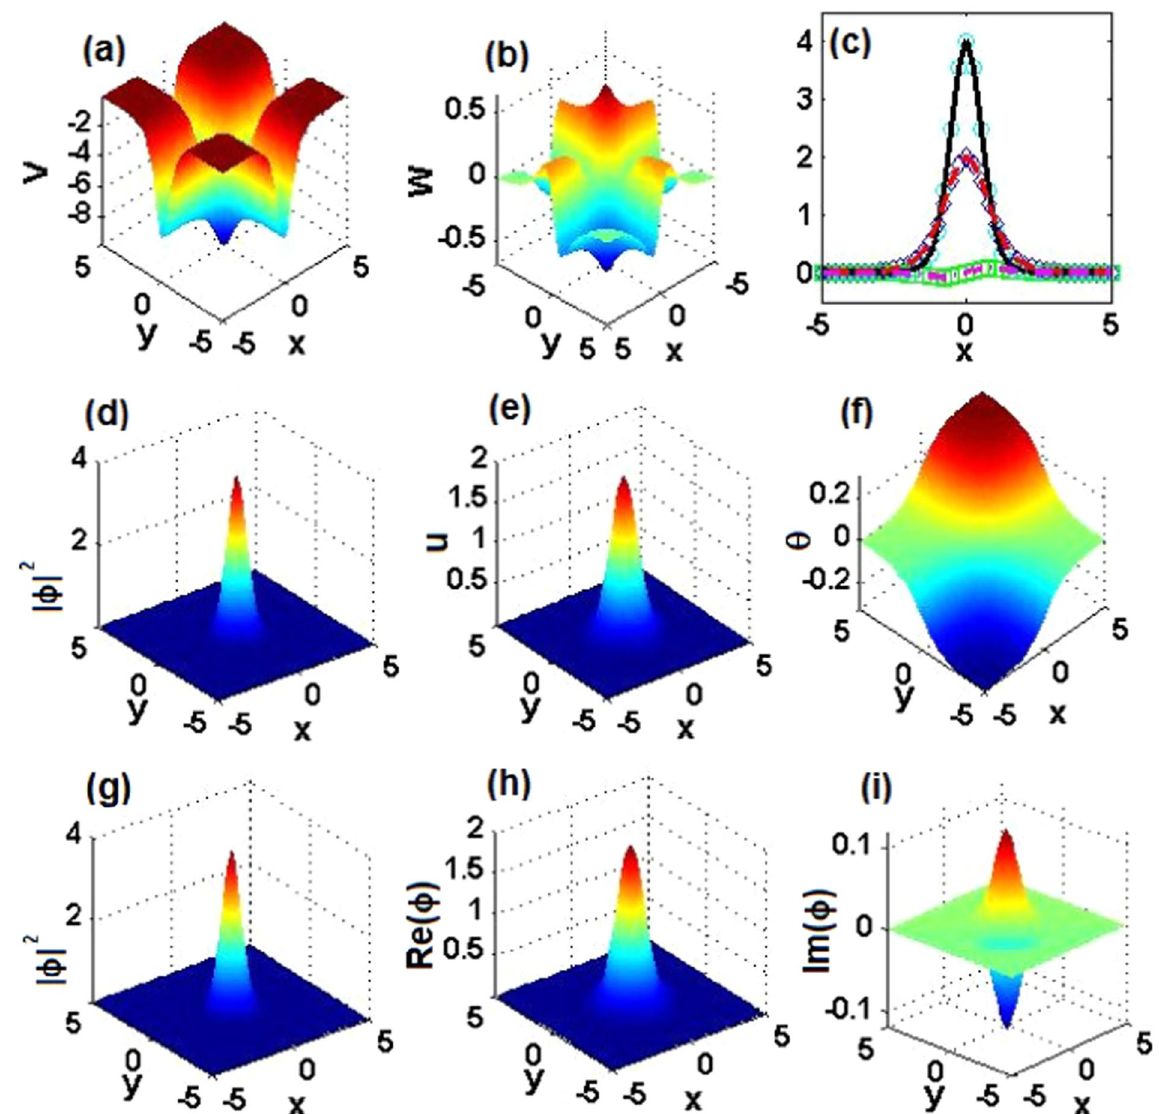
Figure 10. 2D PT -symmetric nonlinear waves for α = 2. The same as in Fig. 9, but for α = 2, and μ = 8 in panel (c). Parameters